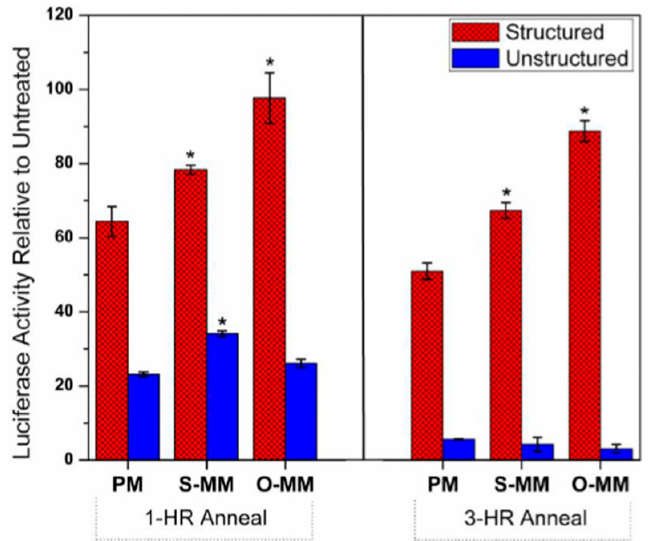
Figure 4. ( A ) Design of firefly luciferase (Fluc) mRNA targets for antisense experiments with unstructured and structured γ PNA probes performed in rabbit reticulocyte lysate. Mismatch sites are indicated with (*). ( B ) Dose-response curves determined after 1 h annealing at 37 °C.